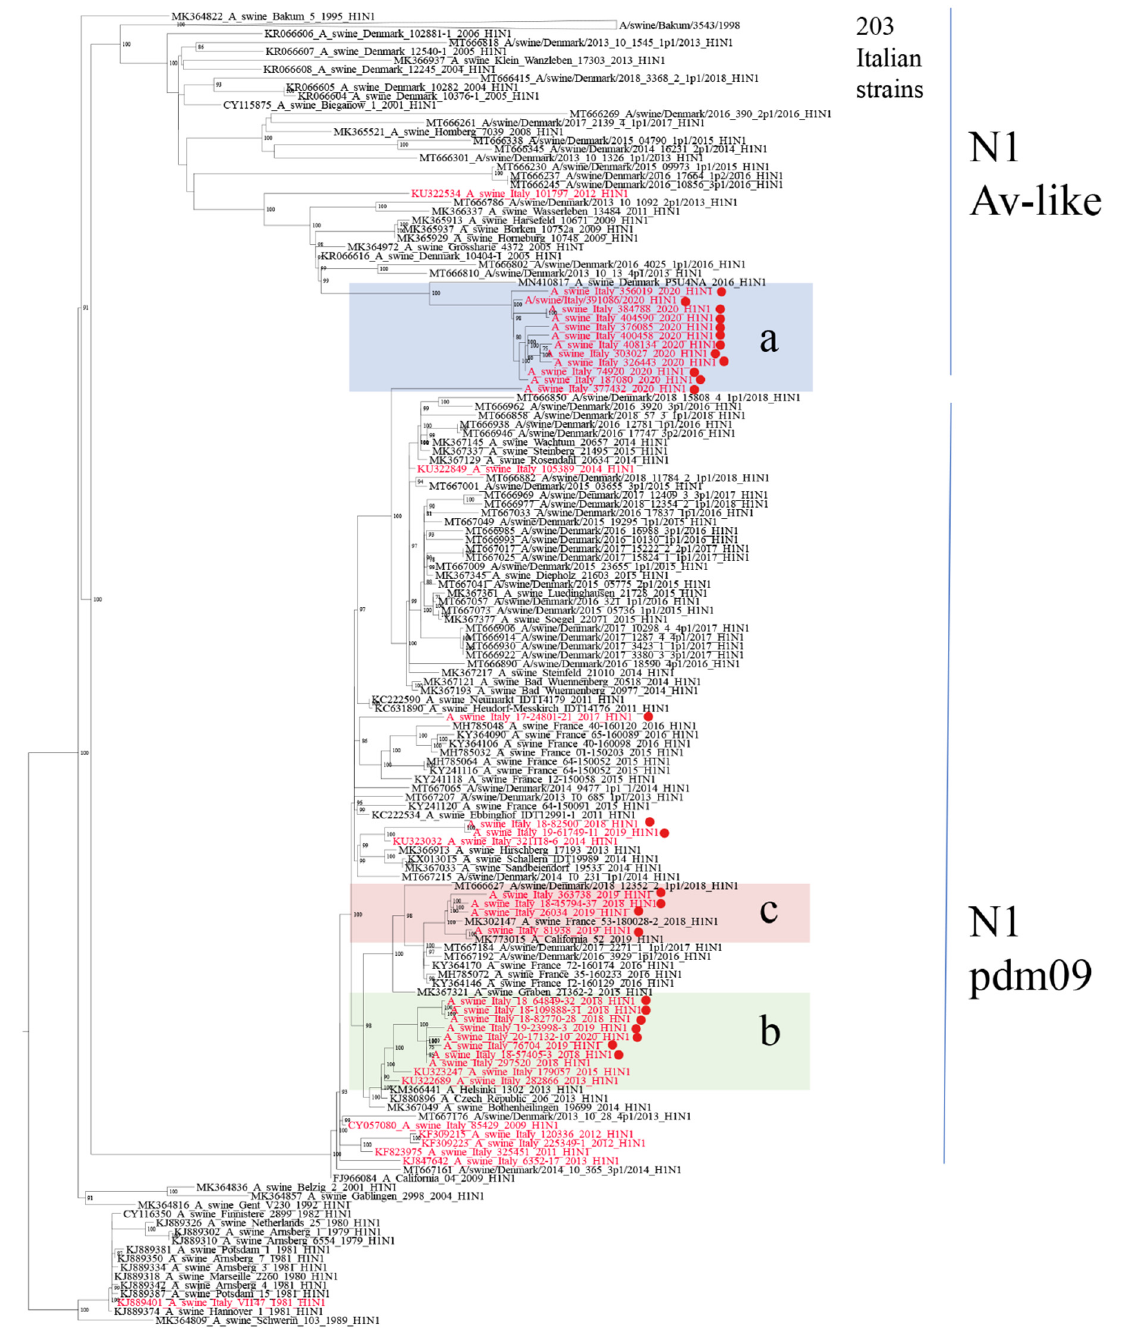
Figure 4. Phylogenetic tree of 199 N1 sequences (1373 nucleotides) of strains sequenced in this work analyzed with 442 representative swine and human N1 sequences, collected from 2009, retrieved from Genbank; the closest NA sequences matching strains in sub-clusters a, b and c are included. Italian sequences are in red with dots highlighting recent strains (2017–2020). The three main sub-cluster ( a – c ) are highlighted in light blue, green, and pink, respectively. To simplify visualization, a group of 203 Italian N1 strains related to the Eurasian avian-like N1 gene A_swine_Bakum_3543_1998 have been collapsed into one branch. Bootstrap values under 70% are not shown; scale bar represents number of nucleotide substitutions per nucleotide site. Sequences retrieved from Genbank are identified by their accession